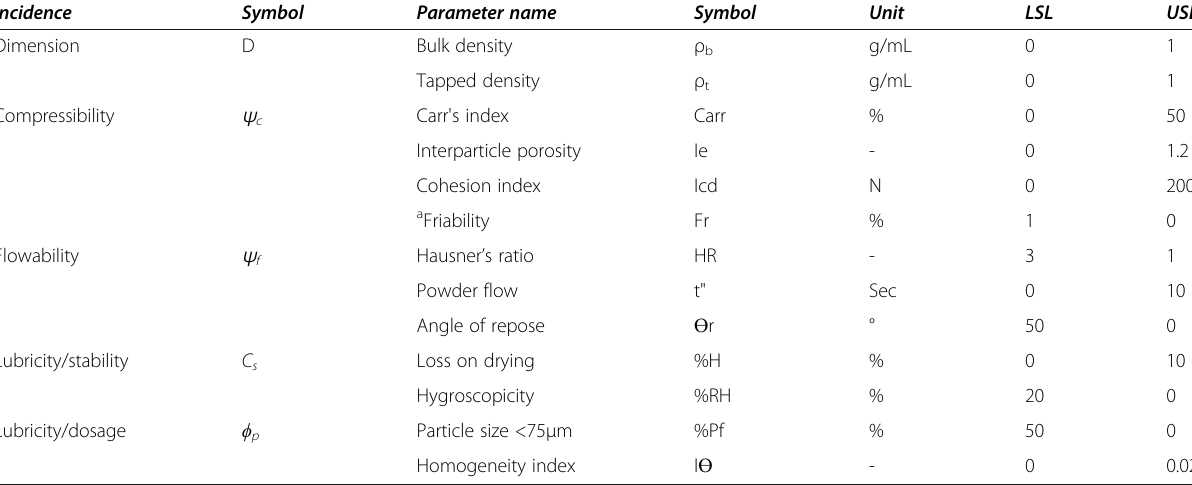
Table 1 Studied parameters and their theoretical specification limits [28] Incidence Symbol Parameter name